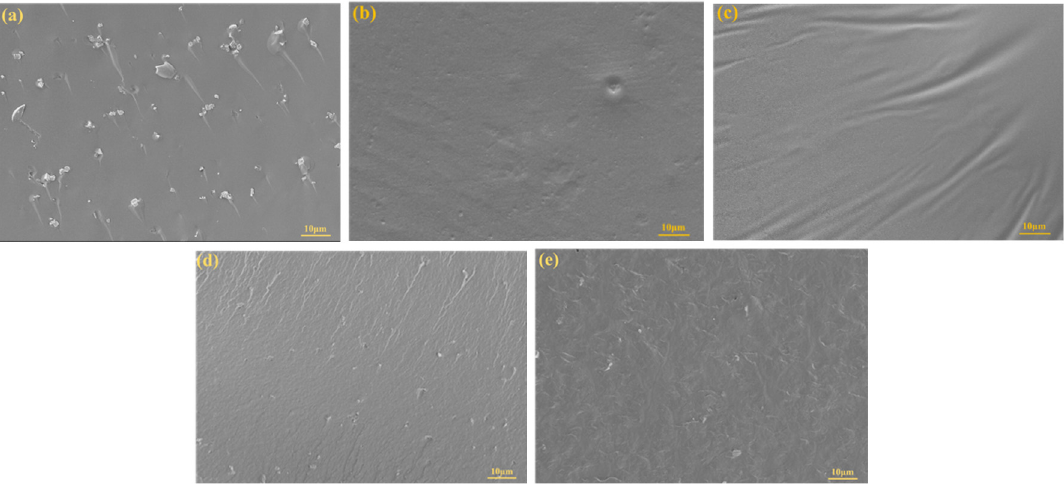
Figure 7. SEM images; ( a ) LPR; ( b ) 10% PBS addition; ( c ) 20% PBS addition; ( d ) 30% PBS addition; and ( e ) 40% PBS addition.